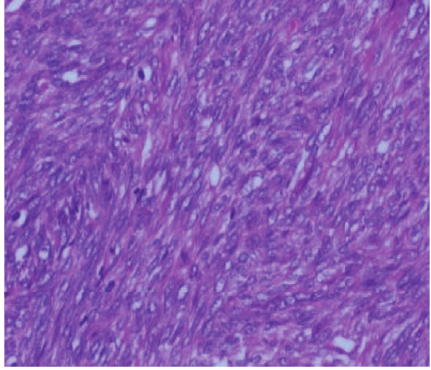
Figure 4: H&E × 40 showing spindle cell sarcoma with hemangiopericytic pattern.